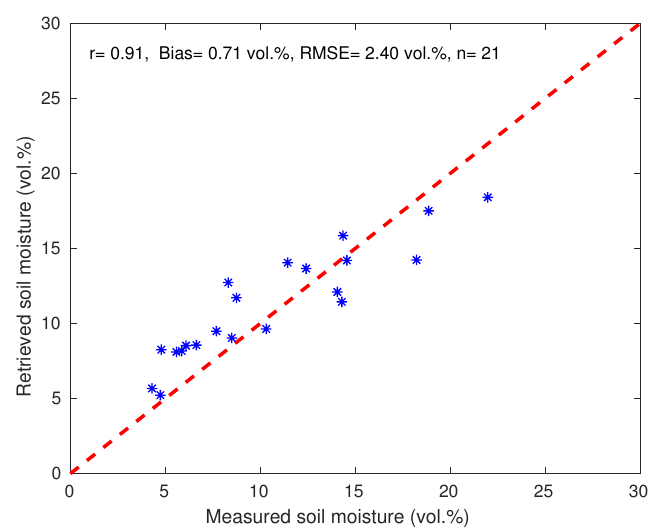
Figure 8. Comparison between retrieved soil moisture using IEM model and ground-truth